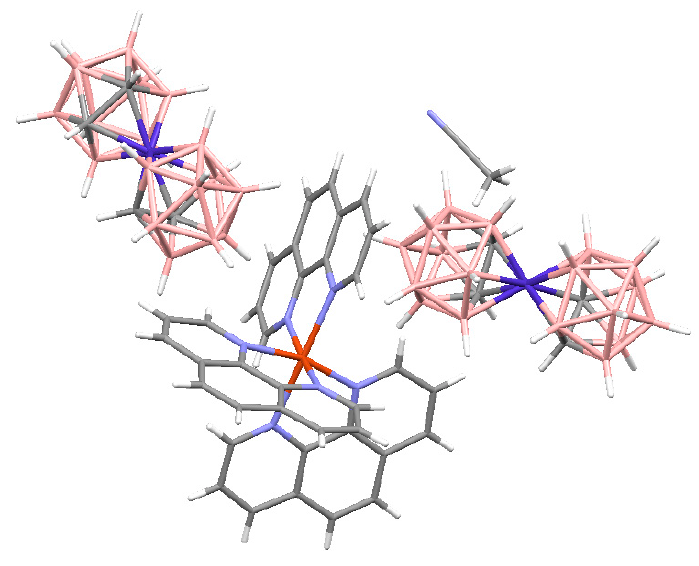
Figure 123. X ray-structure of [Cu(Phen) 3 ][3,3’-Co(1,2-C 2 B 9 H 11 ) 2 ] 2 .